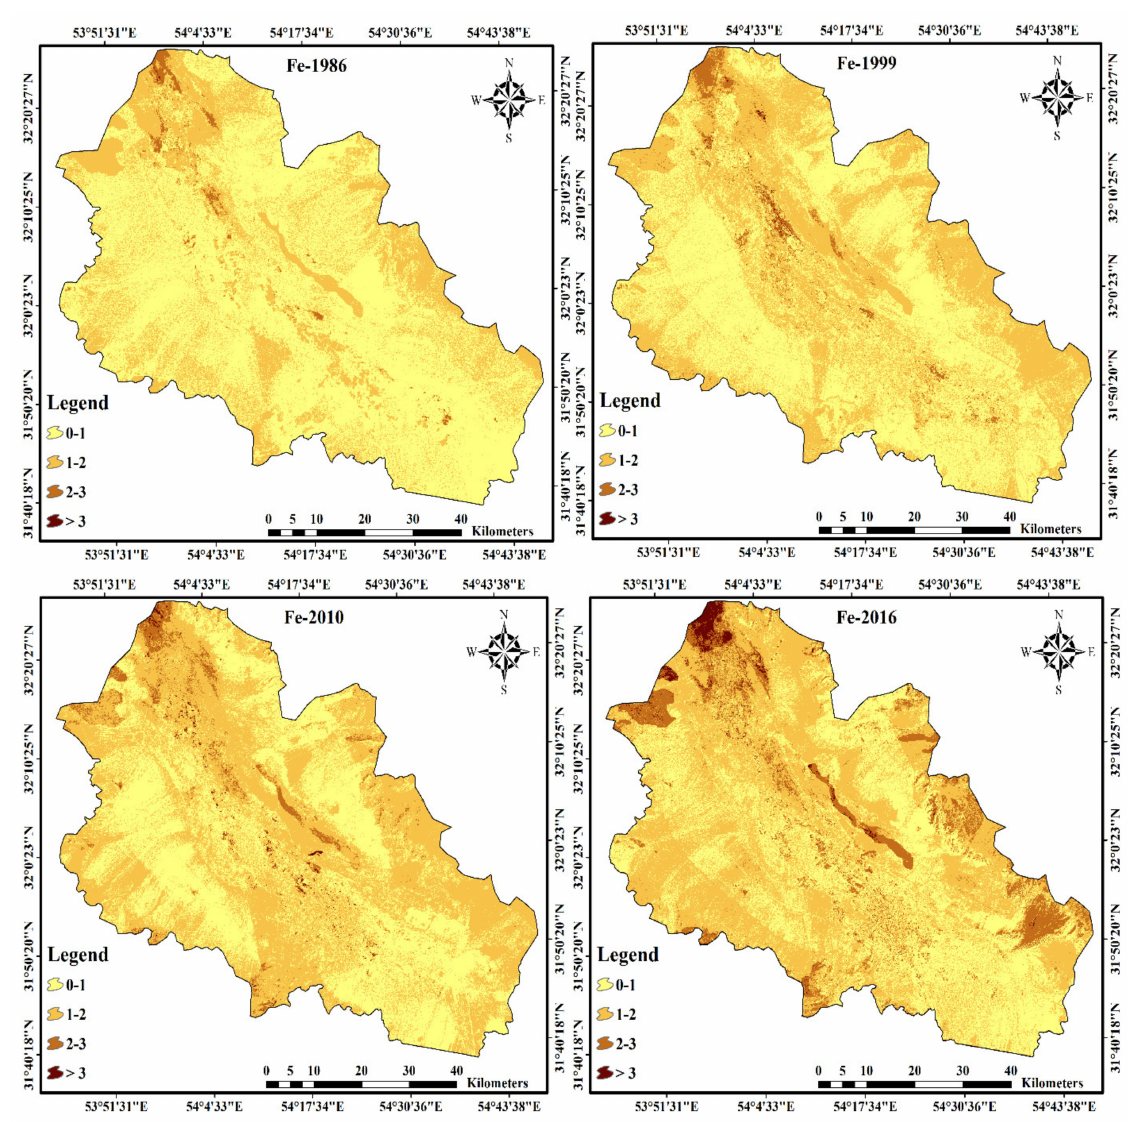
Figure 6. The spatial prediction of Fe (mg/kg − 1 ) for 1986, 1999, 2010, and